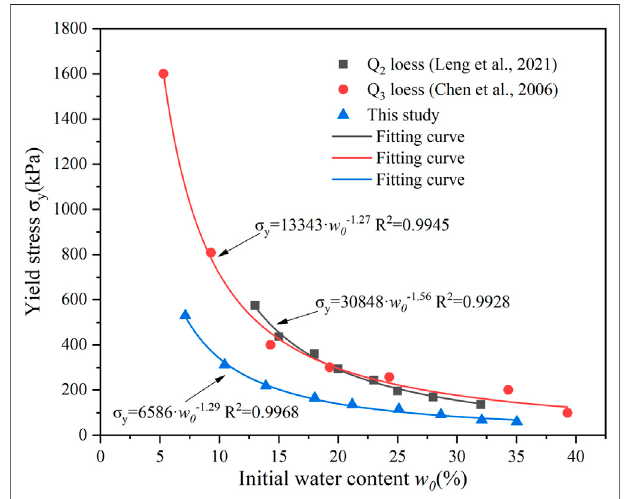
FIGURE 6 | Variation of compression index C c with vertical stress for intact loess at different water